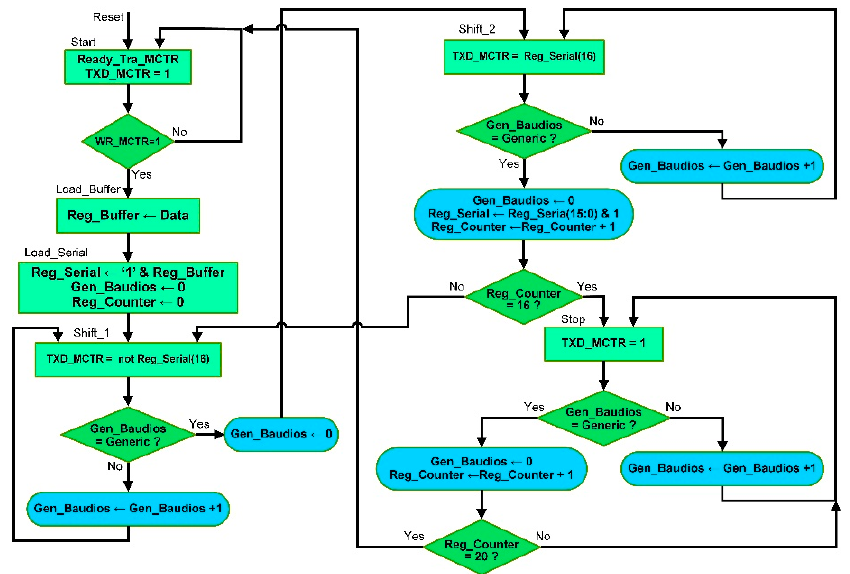
Figure 12. Control Unit for the MCTR Entity Transmitter FSMD.